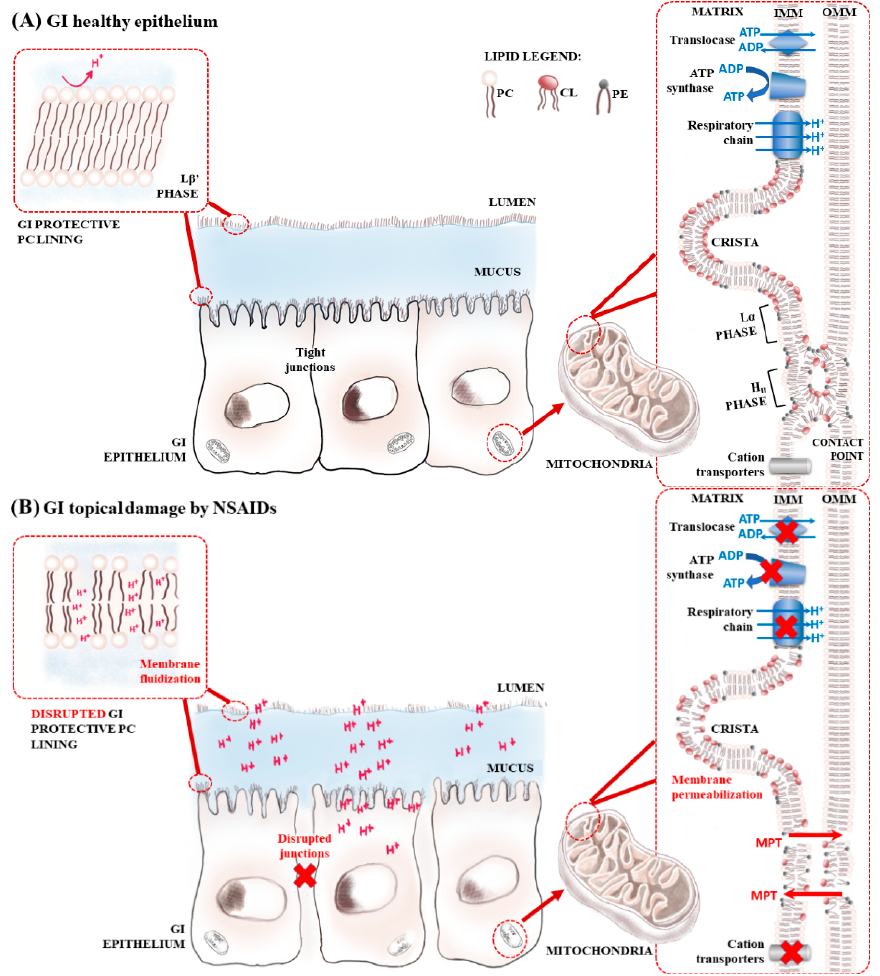
Figure 1. ( A ) Schematic representation of the gastrointestinal (GI) epithelium containing extracellular and cellular phospholipid linings rich in phosphatidylcholine (PC) in the gel phase (L β′ ), which constitute a protective barrier of the GI mucosa against the attack of luminal acid (H + ). The mitochondria outer and inner membranes (OMM and IMM) containing typical crista and contact points rich in bilayer prone phospholipids (e.g., PC) that produce lamellar phases (L α ) and non-lamellar prone lipids (e.g., Cardiolipin (CL) and phosphatidylethanolamine (PE)) that produce inverted hexagonal phases (H II ) are also represented. ( B ) Schematic representation of GI topical damage depicting the disruptive effect of non-steroidal anti-inflammatory drugs (NSAIDs) on the GI protective phospholipid lining. On the right are represented the possible mechanisms by which NSAIDs cause mitochondrial toxicity: inhibition of respiratory chain; inhibition of ATP synthase and translocase; blockage of cation transporters; and membrane permeabilization with the formation of membrane permeability transition pores (MPT).